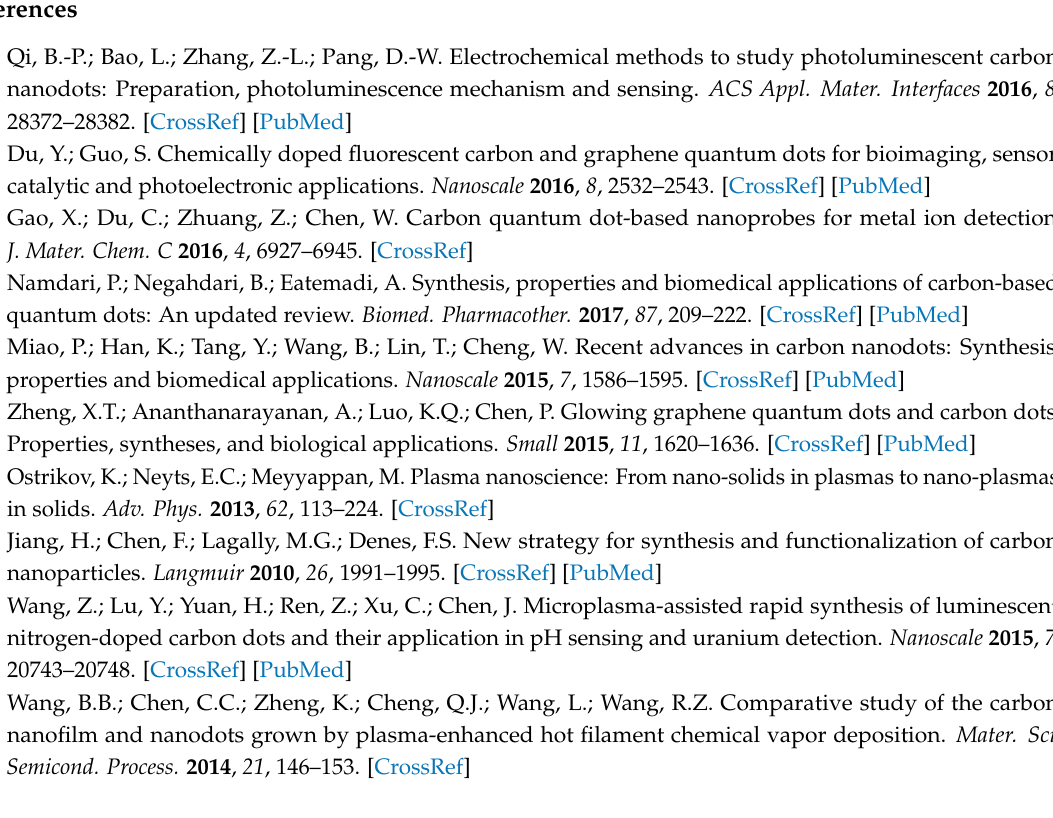
Figure S1: TEM images of the as-prepared C-dots; Figure S2: The deconvolution of the C 1s, N 1s, and O 1s XPS peaks from the O 2 /CCP of the mixture of CA and [EMIM]N(CN) 2 ; Figure S3: Plot of the normalized PL intensity against the UV-Vis absorbance for the determination of the quantum yield; Figure S4: The fluorescence spectra of the C-dots collected after different dialysis times; Figure S5: TEM images of the C-dots dialyzed for two hours and their size distribution; Figure S6: Up-conversion emissions of the prepared C-dots under different wavelength excitations; Table S1: The UV-Vis and fluorescence spectra of the products obtained by CCP